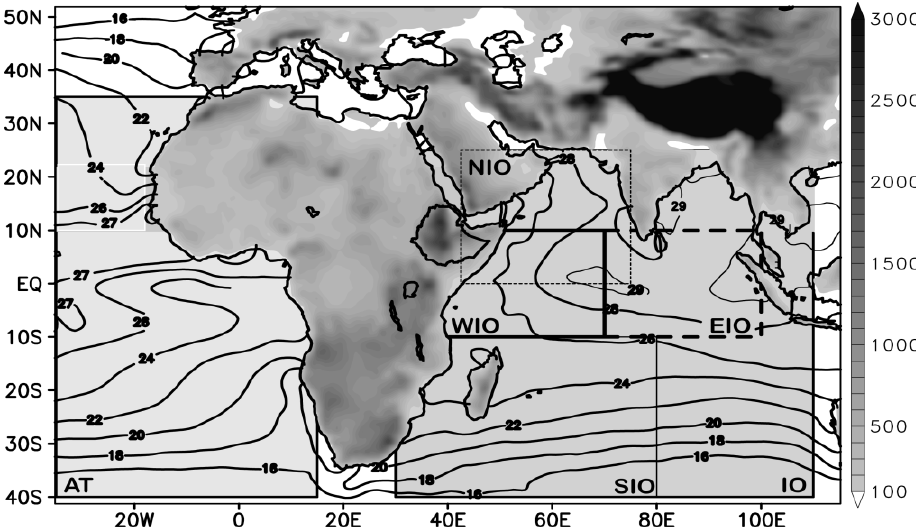
Figure 2. Model domain topography (shading, m) and 1971–2000 sea surface temperature (SST) climatology for July (contours; ° C). Labeled boxes show ocean basin areas used for SST sensitivity experiments. AT (40°S–35°N, 30°W–15°E), NIO (0°–25°N, 40°–75°E), WIO (10°S–10°N, 35°–70 ° E), EIO (10 °S– 10 ° N, 70°–100 ° E), SIO (10°–40°S, 30°–80°E), Ocean, Western Equatorial Indian Ocean, Eastern Equatorial Indian Ocean, Southern Indian Ocean, and Indian Ocean. Border of Ethiopia is delineated in dark bold